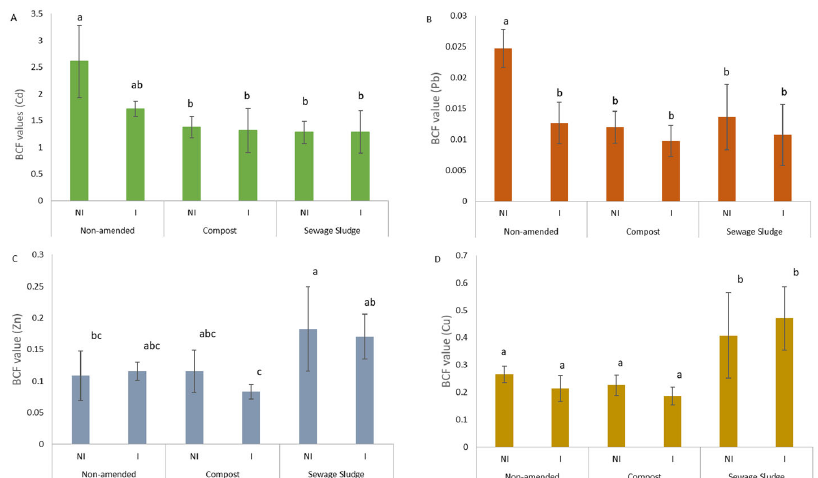
Figure 2. BCF values calculated as the plant part metal concentration over the total metal concentrations: Cd ( A ), Pb ( B ), Zn ( C ), and Cu ( D ). Significant differences between conditions are indicated by the different letters of α = 0.05.